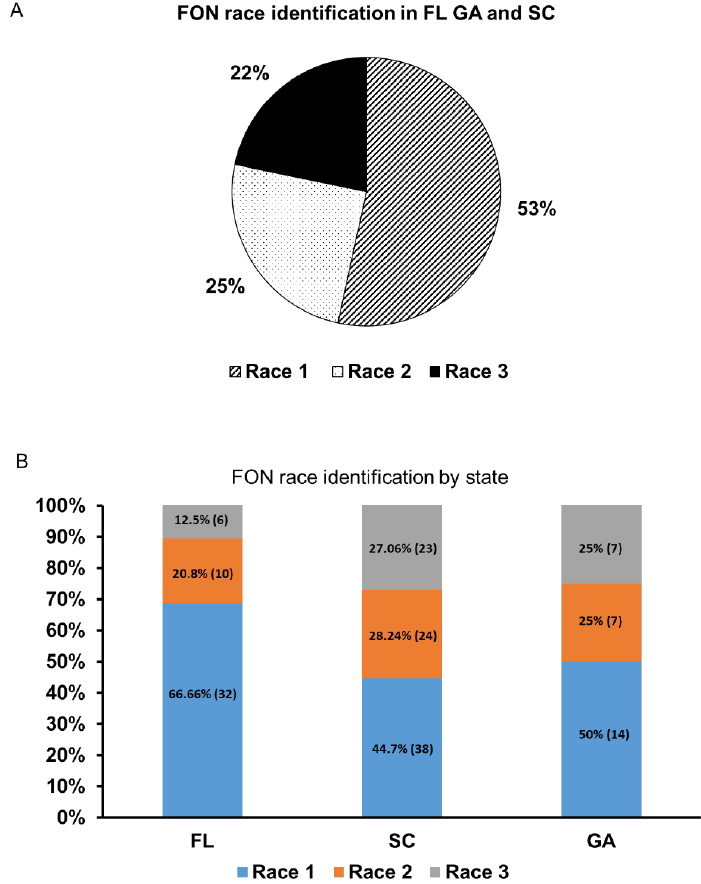
Figure 4. Molecular test results for race identification in states from which samples were taken. ( A ) Race distribution of all states tested. ( B ) Race distribution of individual state samples (FL: Florida, SC: South Carolina, and GA: Georgia). Race 1 = blue, race 2 = orange, race 3 = grey. The number of each race is labeled in the colored section corresponding to the race and